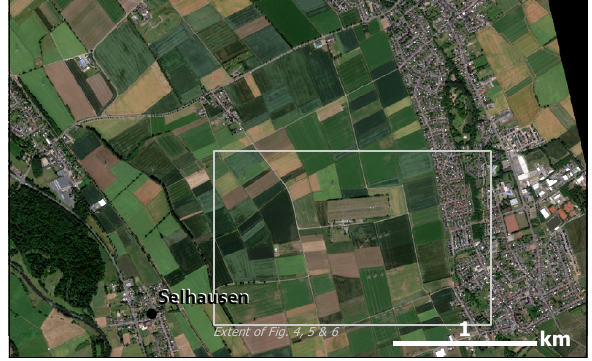
Figure 3. Subset of the WorldView-2 image (11.06.2014).